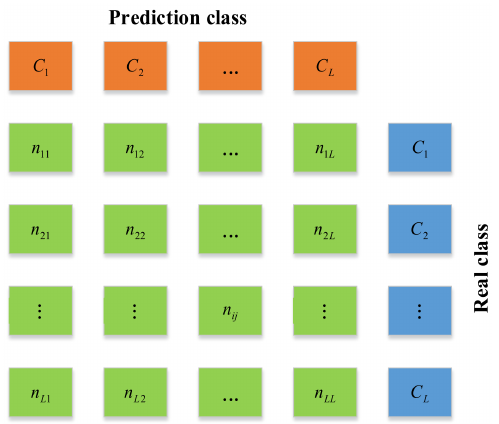
Figure 5. Graph of the multiclassification confusion